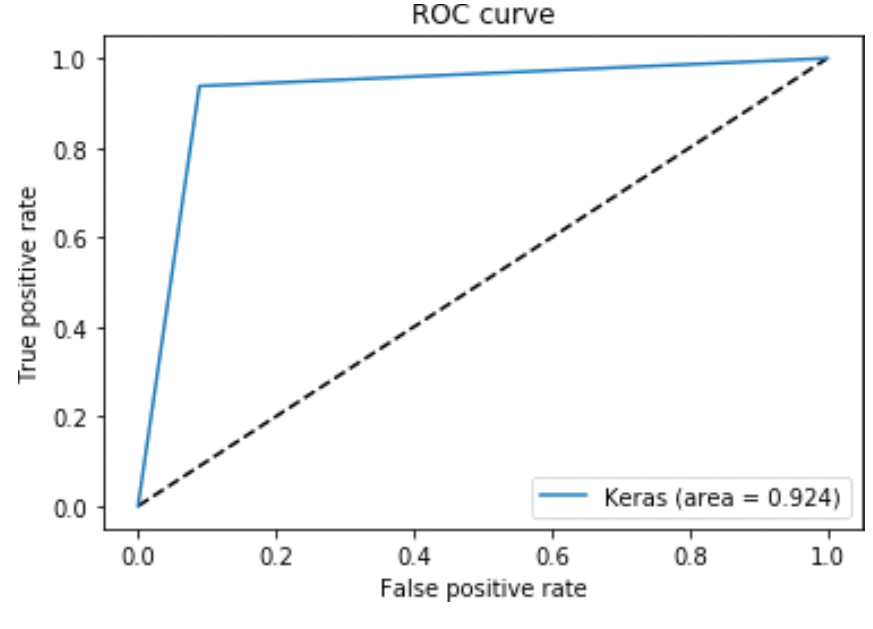
Figure 12: ROC curve for 70% training using LSTM in frequency domain